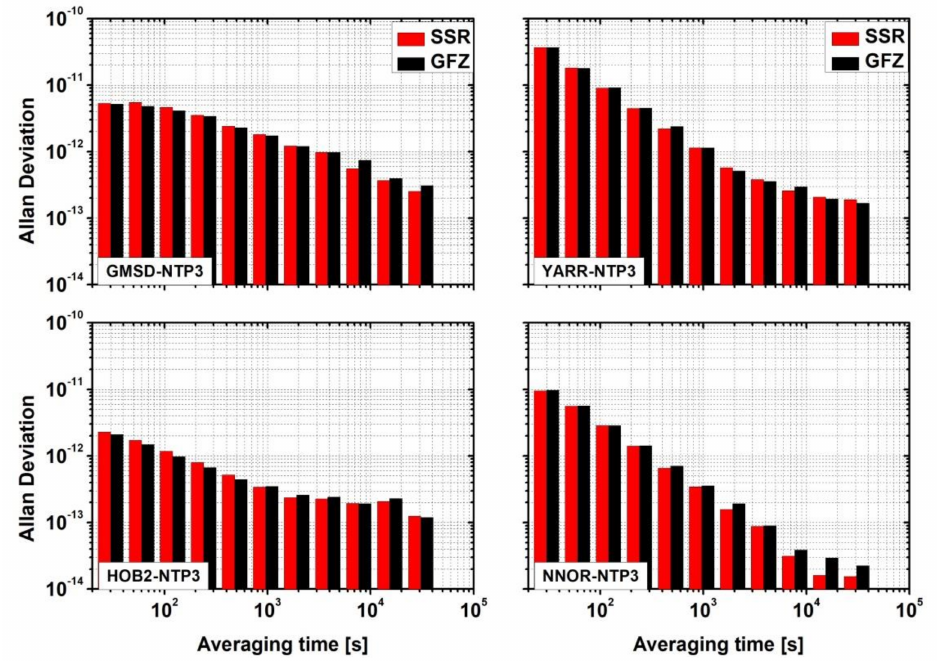
Figure 6. GPS Allan deviation (ADEV) for SSR and GFZ